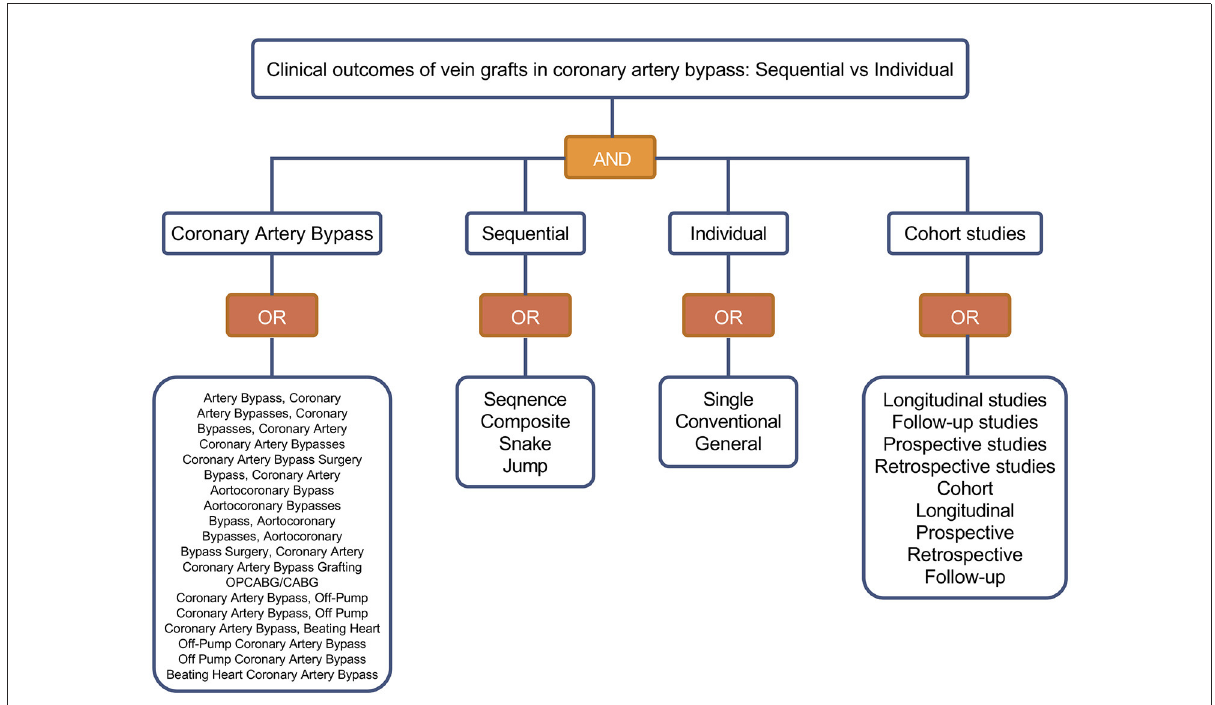
FIGURE1 MeSH search terms used when searching